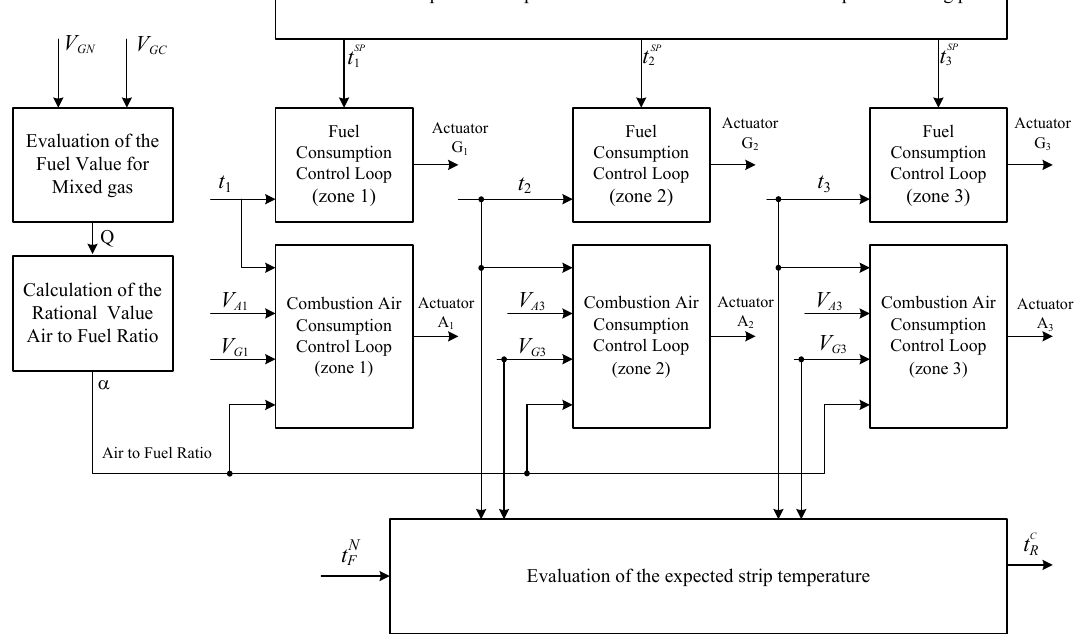
Figure 5. Structural diagram of the heating control system at Mill 2500, “Magnitogorsk Iron and Steel Works Inc”, Magnitogorsk, Chelyabinsk,